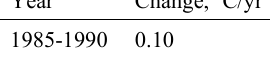
Figure 5. Precipitation changes, 1985 to 2020.